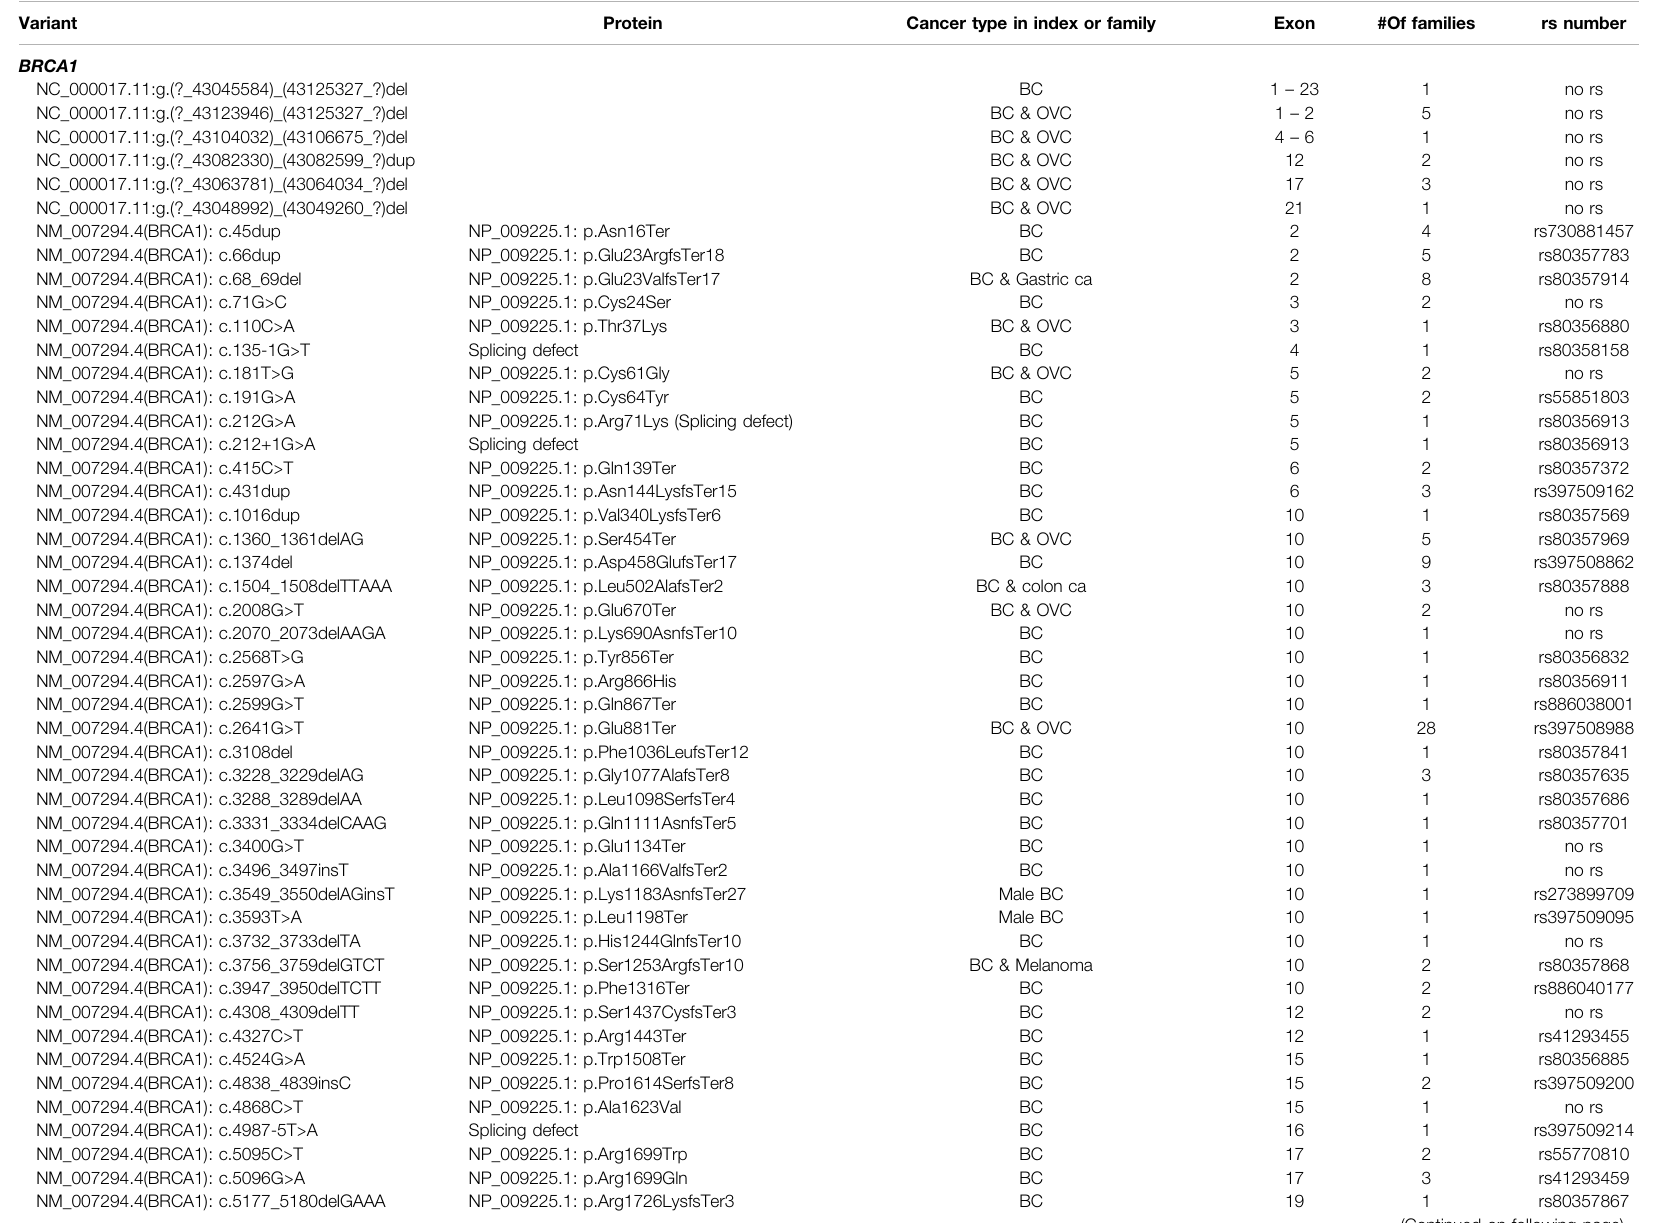
TABLE 5 | Actionable BRCA1/2 variants (likely- to pathogenic) identi fi ed for the entire SA cohort ( n =